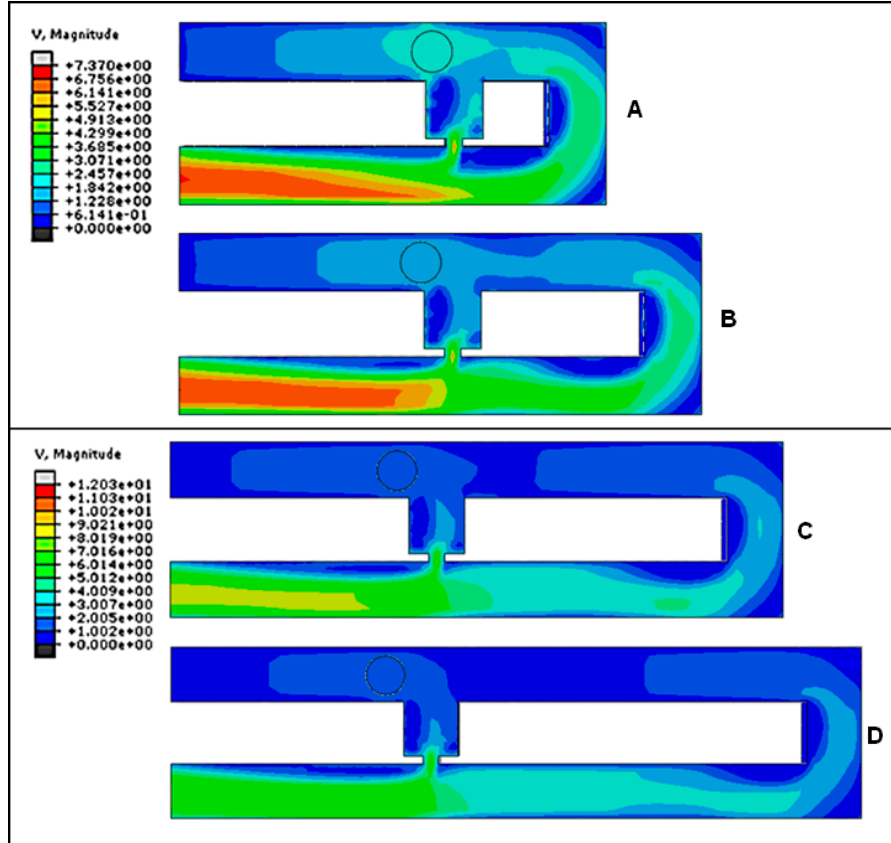
Figure 4. Velocity of fluid before cell trapping for single-cell trapping model with trapping hole width of 2 μ m for Rh Main / Rh Trap ratios of ( A ) 1.5; ( B ) 2.5; ( C ) 3.5; and ( D ) 4.5. V represents the fluid’s velocity in μ ms − 1 .